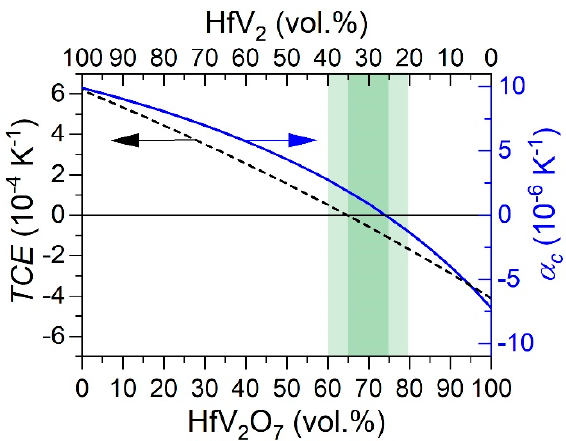
Figure 1. Variation of the temperature coe ffi cient of elasticity TCE (black dashed line) and linear coe ffi cient of thermal expansion α c (blue solid line) of composite material HfV 2 –HfV 2 O 7 depending on the volume fractions of the individual constituents. The region of interest is highlighted in green.